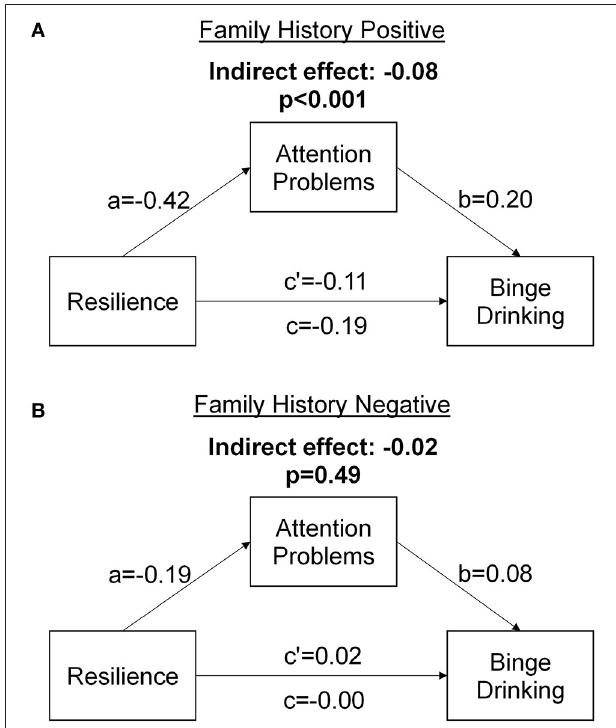
FIGURE 2 | Mediation models demonstrating the mediating effect of Barrett Impulsiveness Scale (BIS) attention scores on the relationship between Connor-Davidson Resilience Scale (CD-RISC) scores and binge drinking scores for (A) individuals with a family history of alcohol use disorder and (B) individuals with no a family history of alcohol use